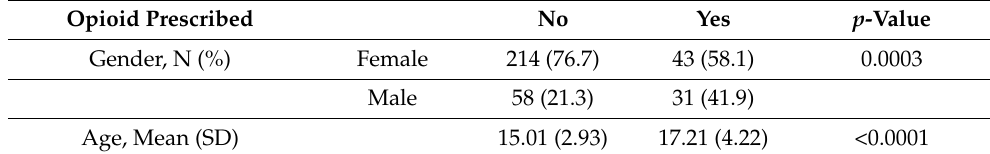
Table 1. Demographics of patients.